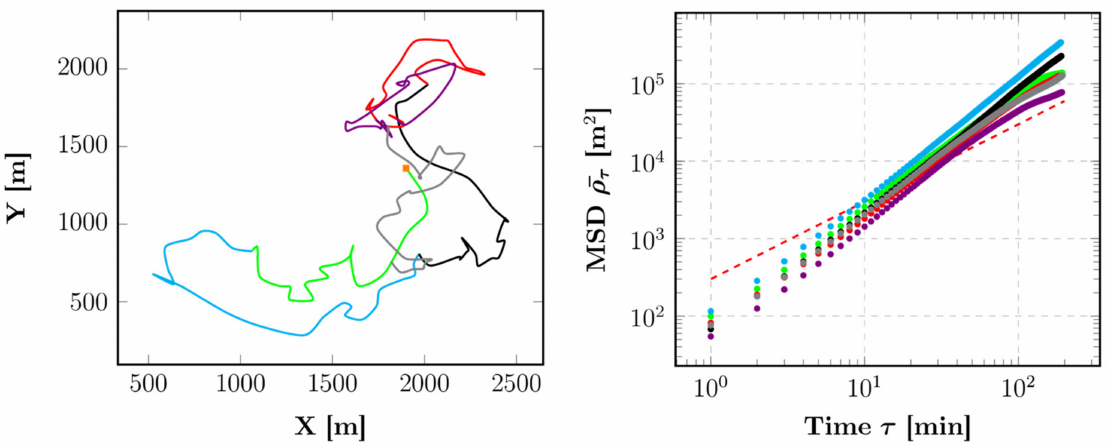
Figure 3. Evolution of the troop position ( left ) with the corresponding MSDs ( right , mean α = 1.46 ± 0.08) for a tracking of 6 consecutive days during high food availability in the dry evergreen forest. The orange square indicates the departure of the troop, and the dashed line represents a line of a unitary slope, i.e., for α = 1.